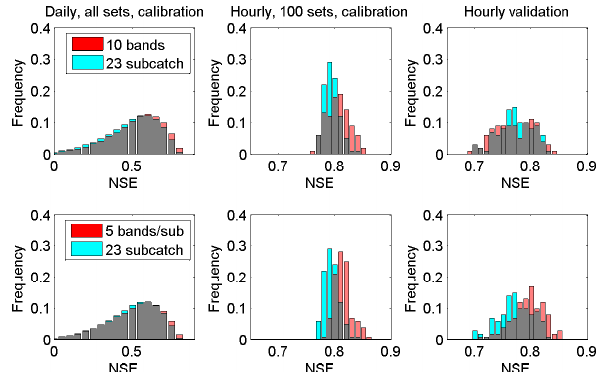
Figure 10. Comparison of model performance of the subcatchment- based model set-up (23 subcatchments) to elevation band set-ups. Top row: comparison to 10 elevation bands (see Fig. 3), bottom row: comparison to a combination of elevation bands and subcatchments (5 bands for each of the 23 subcatchments). Left column: distri- bution of the Nash–Sutcliffe (NSE) efficiency computed at a daily time step for the calibration period (shown are parameter sets with NSE > 0); centre column: NSE distribution of the 100 sets with the highest NSE values at the daily time step run at hourly time step for the calibration period; right column: same 100 sets run at an hourly time step for the validation period. The same 35000 parameter sets are run for all three model